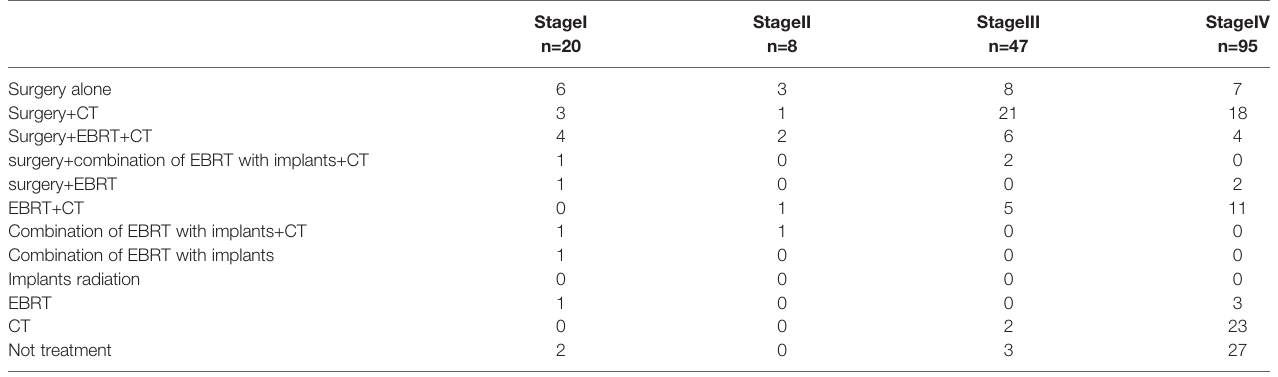
TABLE 2 | Treatment at each stage for neuroendocrine tumors (NETs) of the endometrium.